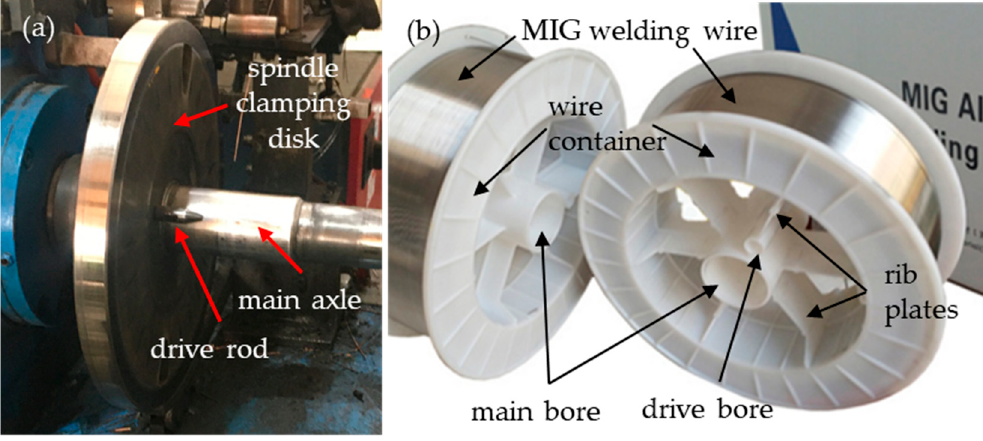
Figure 2. The spindle structure of a current winding machine ( a ) and the welding wire spool ( b ).